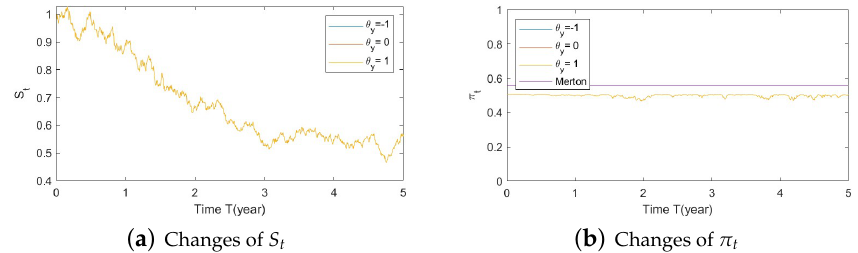
Figure A23. Illustrate the impact on ( a ) stock prices and ( b ) optimal stock allocations when varying θ y ( e . g ., θ y = − 1,0,1 ) .